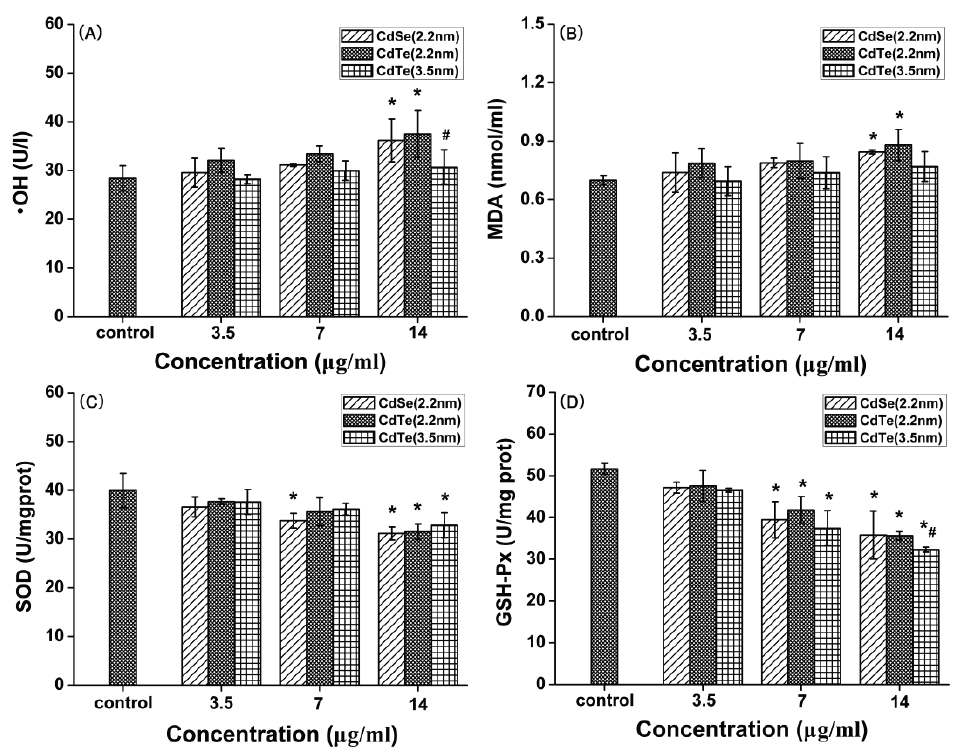
Figure 6. The hydroxyl radical (•OH), malondialdehyde (MDA) levels, superoxide dismutase (SOD) and glutathione peroxidase (GSH-Px) activities in L929 mouse fibroblasts after being treated with three types of CdTe QDs (3.5, 7, and 14 μ g/mL) at 24 h. Data are the mean ± SD of three separate experiments. Significance was indicated by: * p